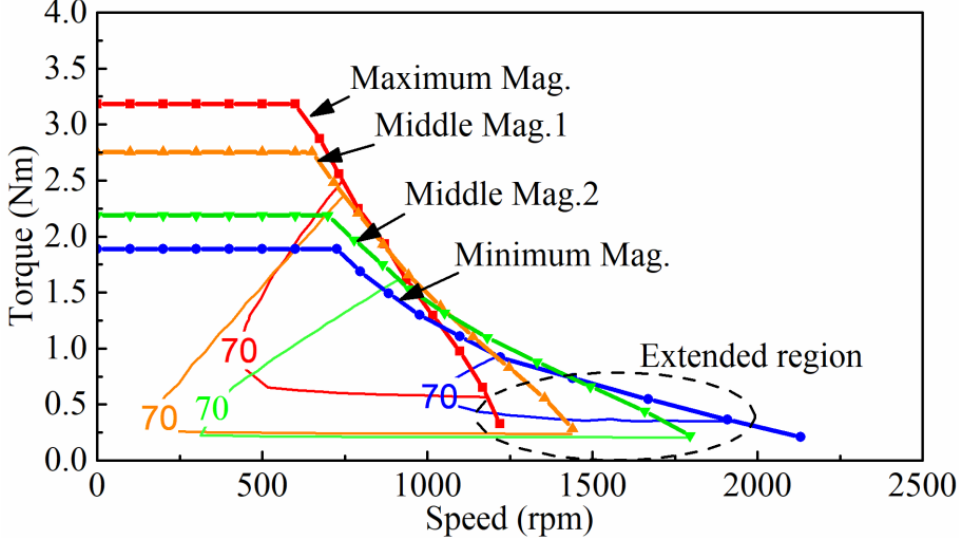
Figure 17. Torque-speed curves in four different magnetization states.